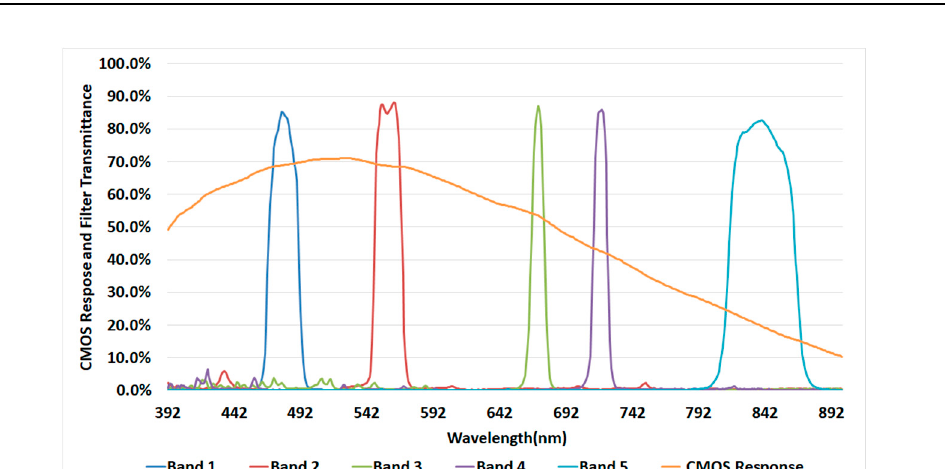
Figure 1. Filter transmittance for each band and spectral response of complementary metal-oxide semiconductor (CMOS) in MicaSense RedEdge-MX.